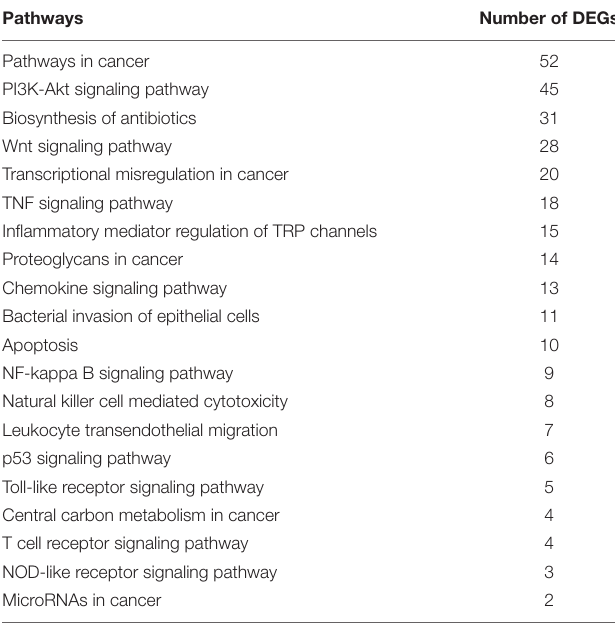
TABLE 3 | Summary of 20 significant immune-related signaling